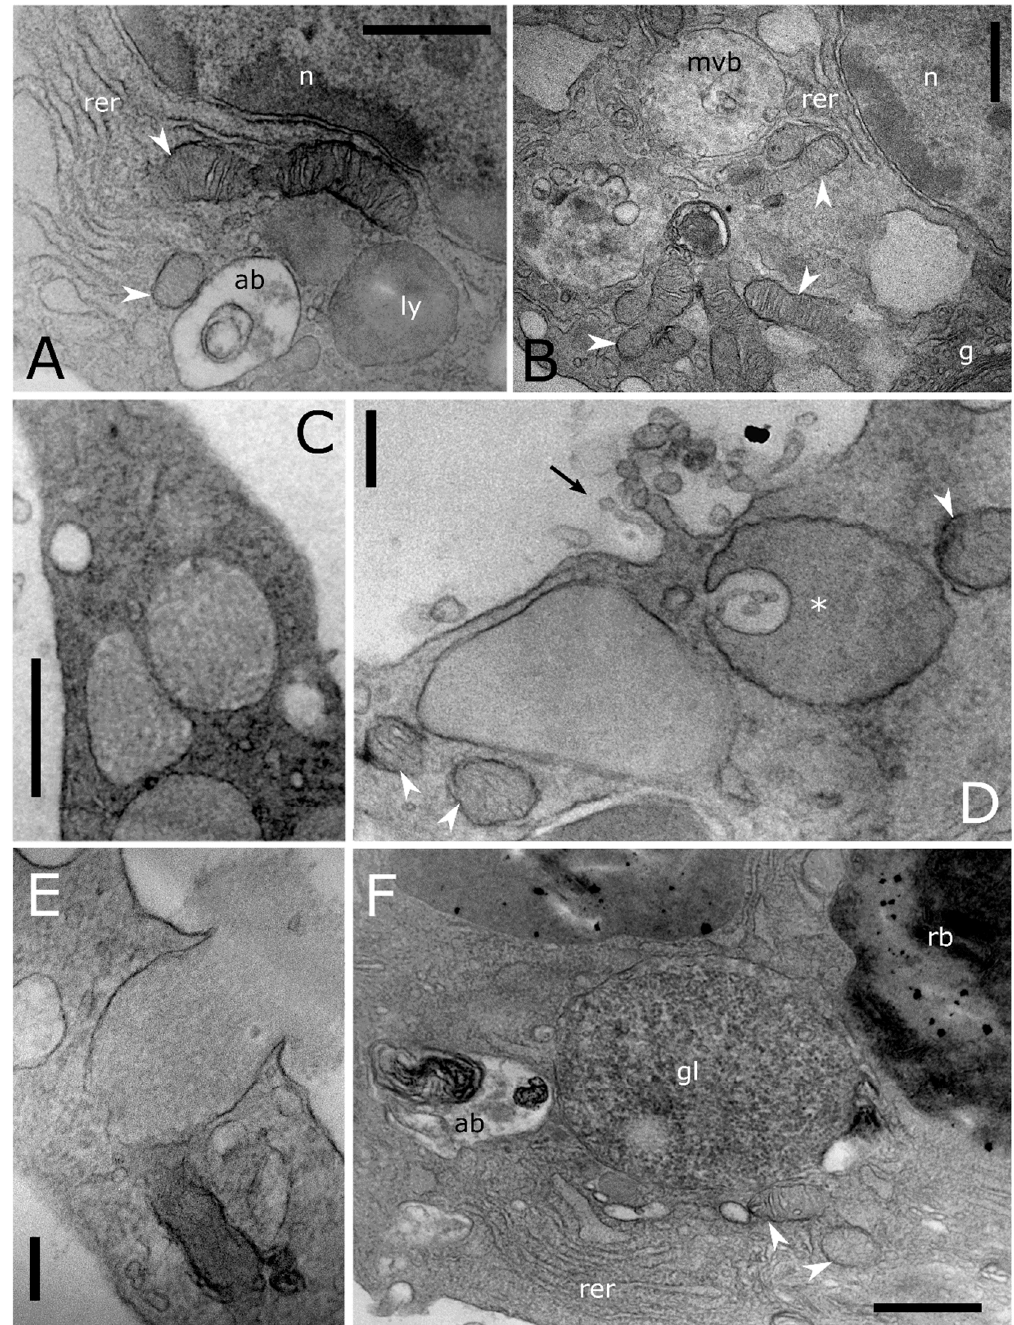
Figure 5. Transmission electron micrographs of cytoplasmic compartment in T. molitor haemocytes. ( A , B ) Details showing enlarged rough endoplasmic reticulum (rer), elongated mitochondria (white arrowheads) with evident cristae, autophagic body (ab), a granule (ly) storing homogeneous electron dense content and a multivesicular body (mvb). ( C ) Granules storing tubular elements. ( D ) Exosomes (black harrow) released in extracellular space by exocytic fusion of the multivesicular body with the plasma membrane. The asterisk indicates a microautophagic process. A lysosome invaginates and forms a bud sequestering cytoplasmic materials. ( E ) Degranulation process through the release of electron dense content in the extracellular medium. ( F ) Granule storing glycogen (gl) are closely adherent to a mitochondrion (white arrowhead). g: Golgi complex, n: nucleus, rb: residual body. Bars: 500 nm ( A – D , F ); 200 nm ( E ).